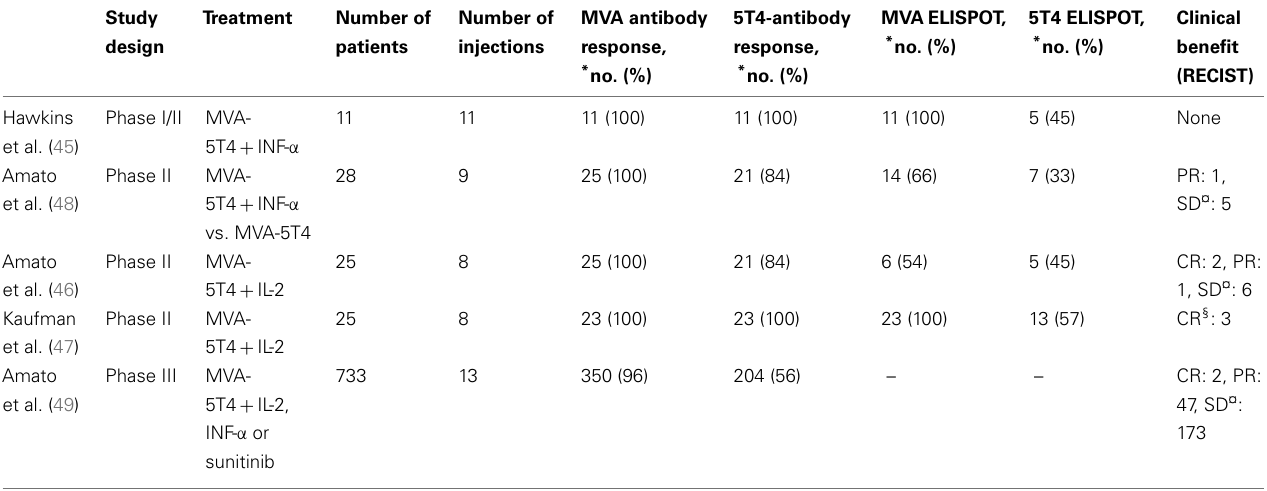
Table 1 | Summary of all clinical trials conducted using MVA-5T4 in the treatment of mRCC.